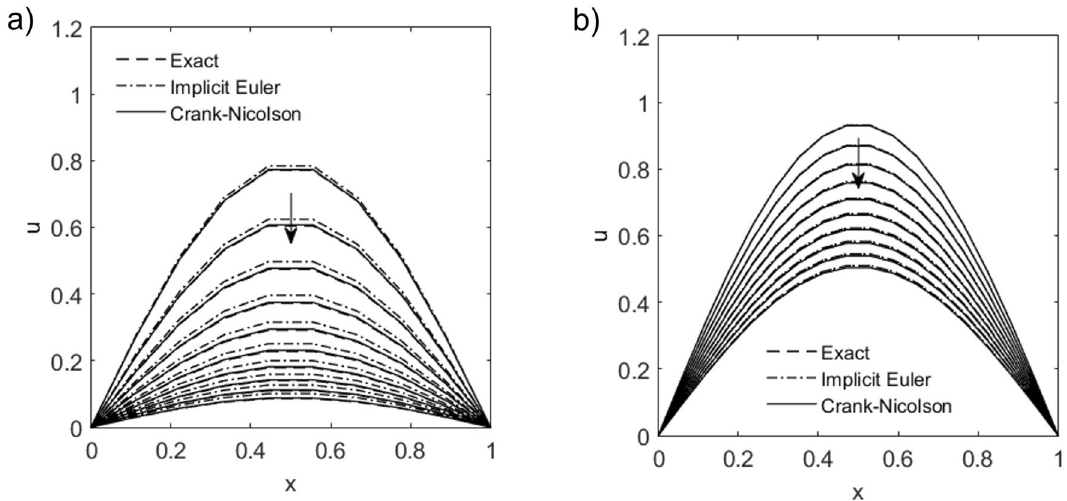
Figure 4. Variational quantum solutions to a 1D heat conduction or diffusion problem for qubit-layers ( a ) 3 -3 and ( b ) n - l 4 -4 in time-increments of 0.1 using implicit Euler and Crank–Nicolson schemes, with n - l = = sin (π x ) and diffusion parameter δ ( 0, 0 ) , initial values u 0 Dirichlet boundary values ( g L , g R ) = = lines denote exact